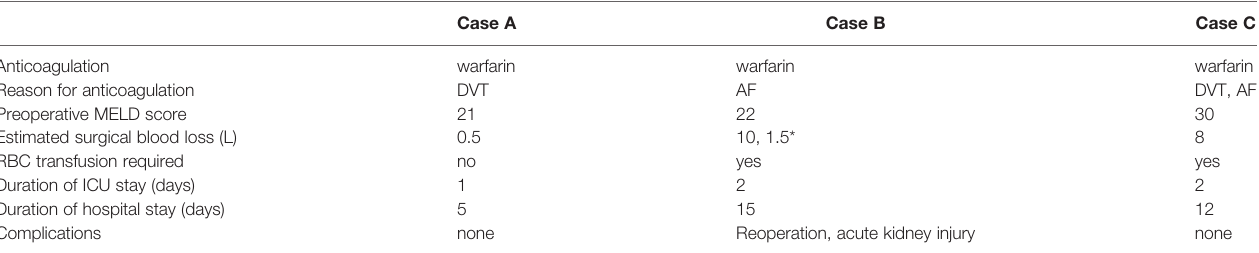
TABLE 1 | Patient characteristics and